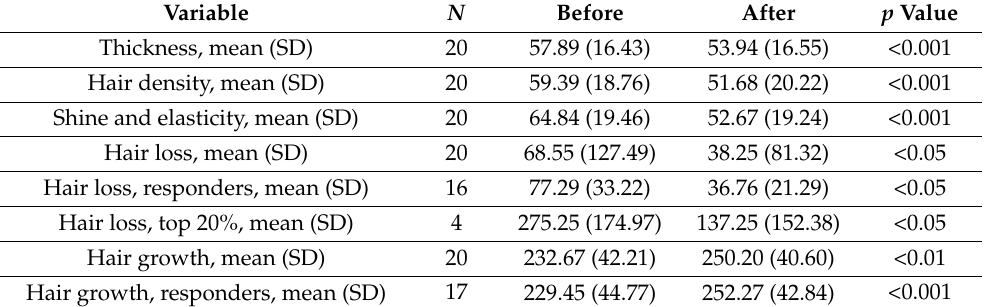
Table 1. Comparison before and after use of Tomorrowlabs [HSF] hair